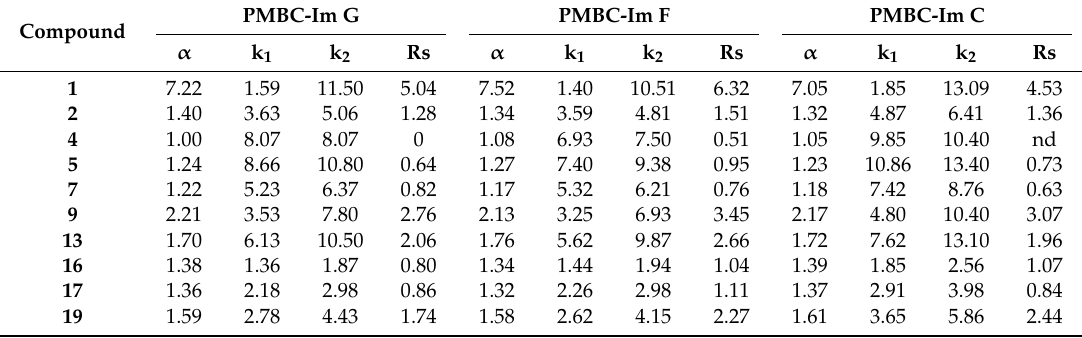
Table 3. Chromatographic results of the enantioselective separations of selected racemic compounds on photochemically immobilized PMBC-Im CSPs: influence of applied solvent for irradiation. Mobile phase: hexane/2-propanol (9/1, v / v ).